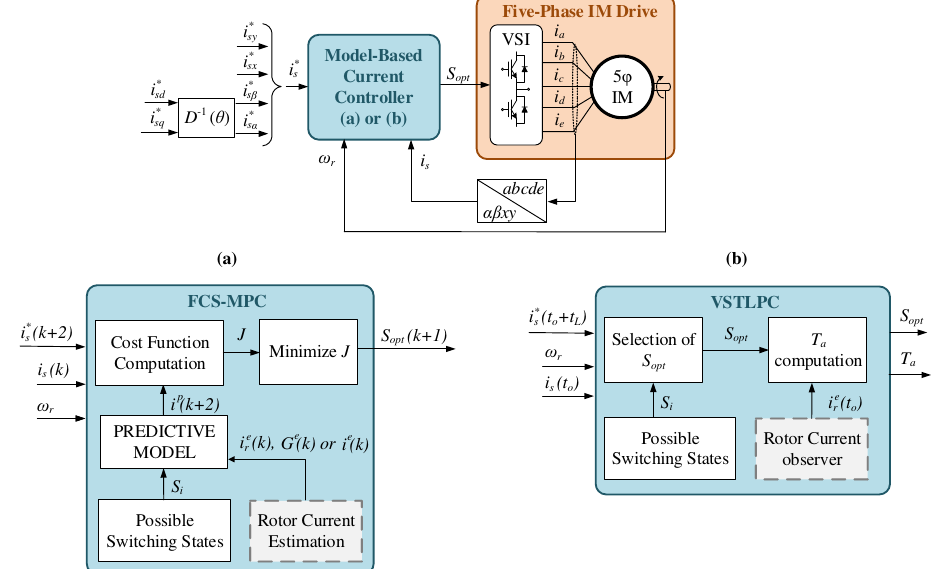
Figure 1. Simplified scheme of the five-phase induction machine (IM) drive current controller using ( a ) finite control set (FCS)-predictice control methods (MPC) and ( b ) variable sampling time lead pursuit controller (VSTLPC)